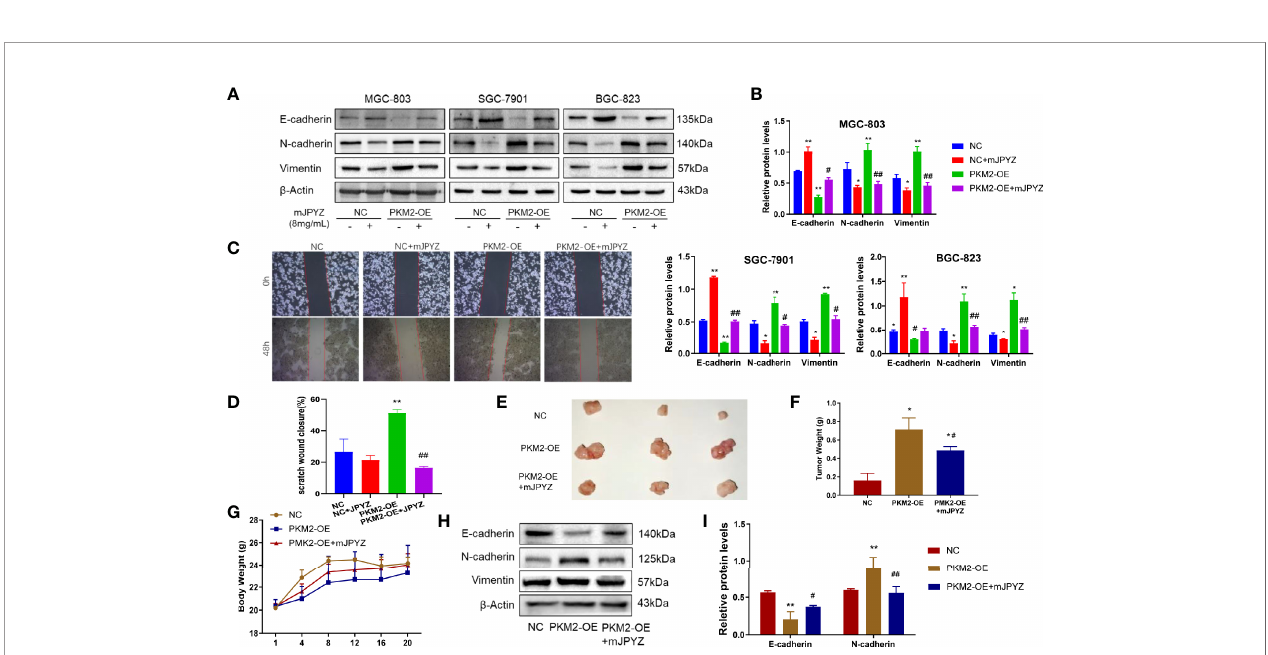
FIGURE 7 | Overexpression of PKM2 reversed the effect of mJPYZ on gastric cancer. (A, B) PKM2 affected the effect of mJPYZ on gastric cancer EMT related proteins. (C, D) Wound healing assay showed overexpression of PKM2 reversed the mJPYZ in fl uence on migration. (E – G) mJPYZ still signi fi cantly inhibited the xenograft tumors growth although overexpression of PKM2, while the mice body weight still. (H, I) Western blotting analysis of overexpression of PKM2 affected the EMT essential proteins in vivo . Data are represented as mean ± SD, n=3 mice or n=3 independent experiments. #P < 0.05, ##P < 0.01 versus PKM2-OE group. *P < 0.05, **P < 0.01 versus control group by one-way analysis of variance (ANOVA) followed by Tukey ’ s post-hoc